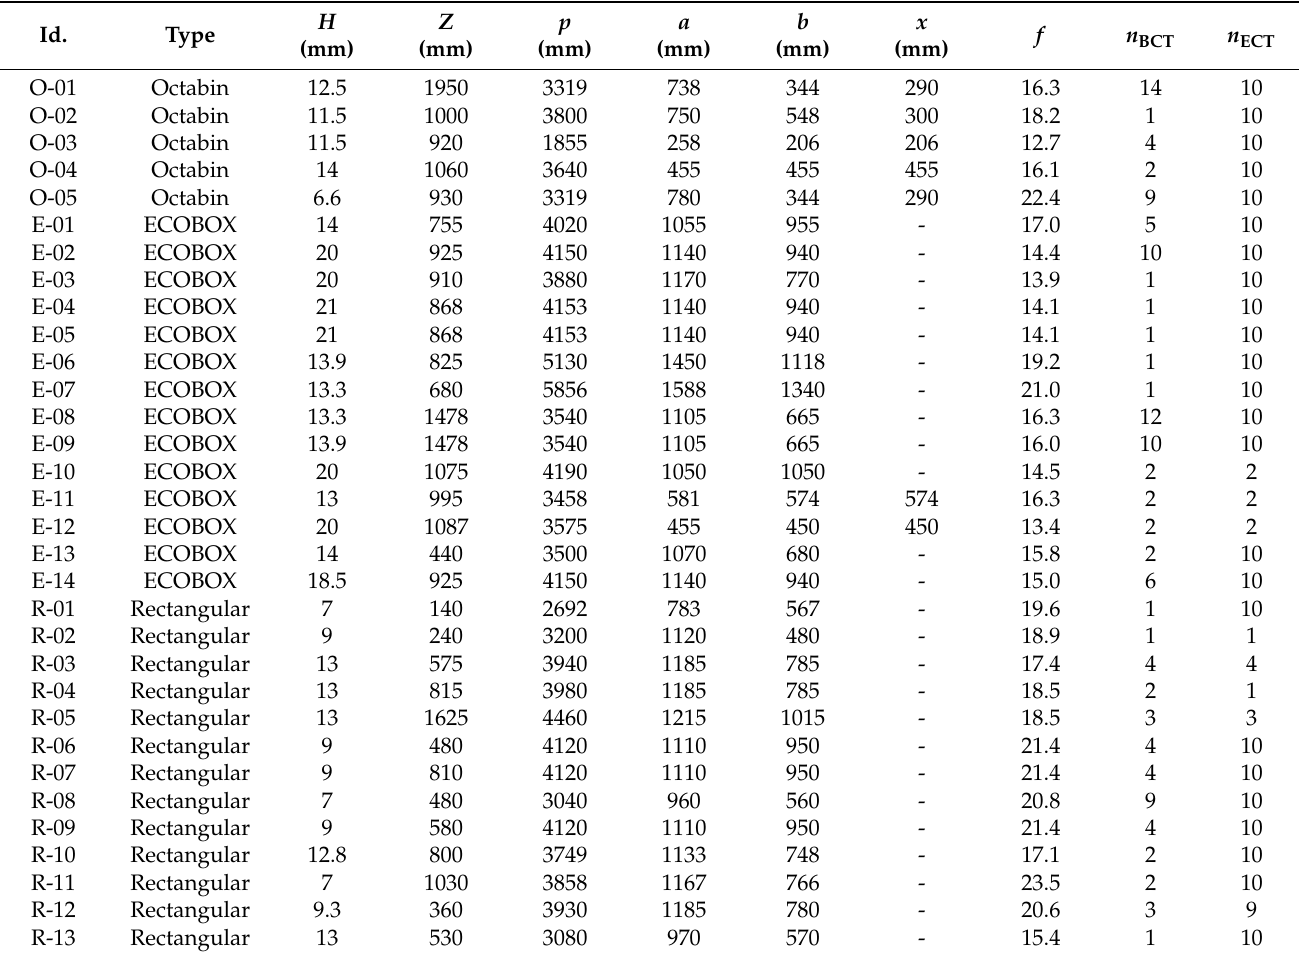
Figure 1. Three different zones of the force-displacement curves resulting from the BCT test. These three curves correspond to the test performed on the three samples of the Id. R-05 of Table 1. Table 1. Data for the tested